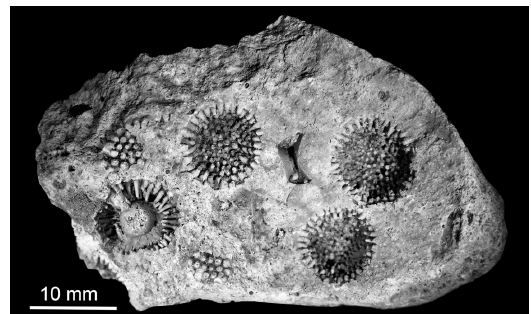
Fig. 12. Natural surface of a fragment of a type 2A boulder showing specimens of Coelosphaeridium sphaericum and a transverse section of a gastropod. RGM 1317649, Itterbeck.